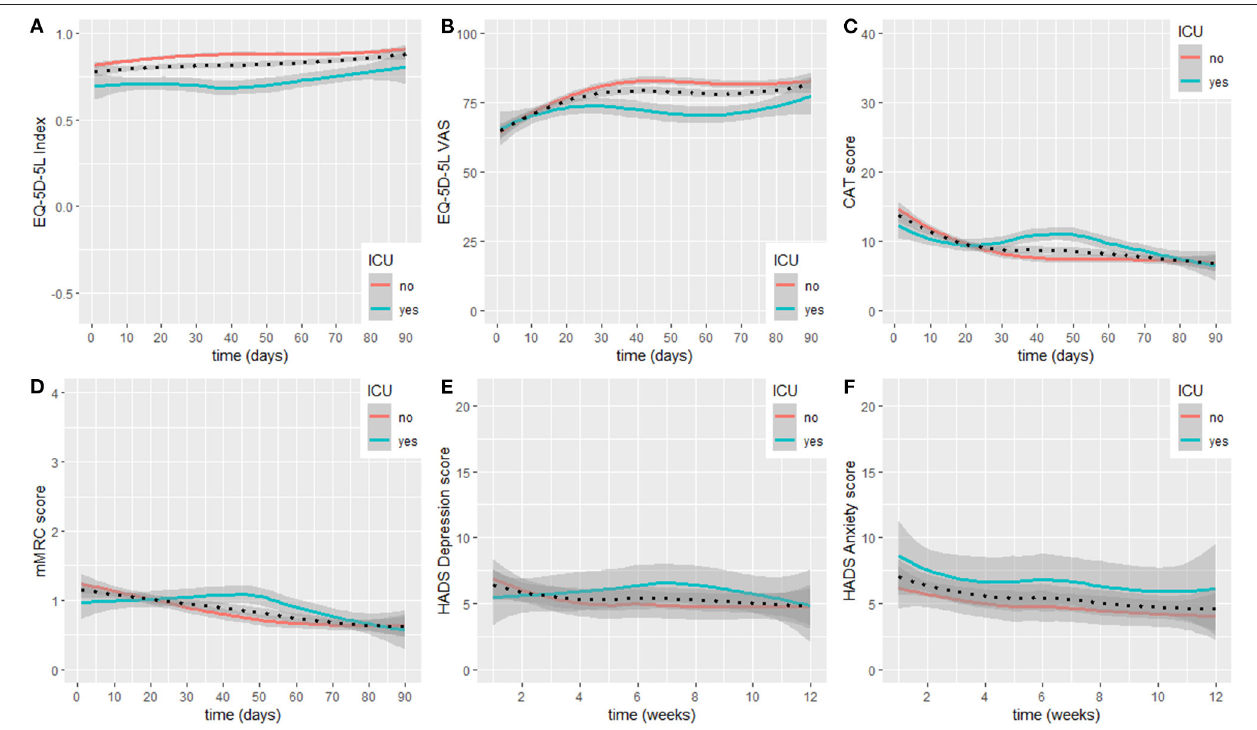
FIGURE 3 | Recovery course for EQ-5D-5L Index (A) , EQ-5D-5L general health VAS (B) , CAT (C) , mMRC (D) , HADS depression (E) , and HADS anxiety (F) . LOESS lines are displayed for the overall sample (dotted line), and individuals admitted to an ICU or not (see legend). ICU, intensive-care unit; CAT, COPD Assessment Test; EQ-5D-5L, European Quality of Life − 5 Dimensions − 5 Levels Instrument; HADS, Hospital Anxiety and Depression Scale; mMRC, modified Medical Research Council; VAS, Visual Analogue